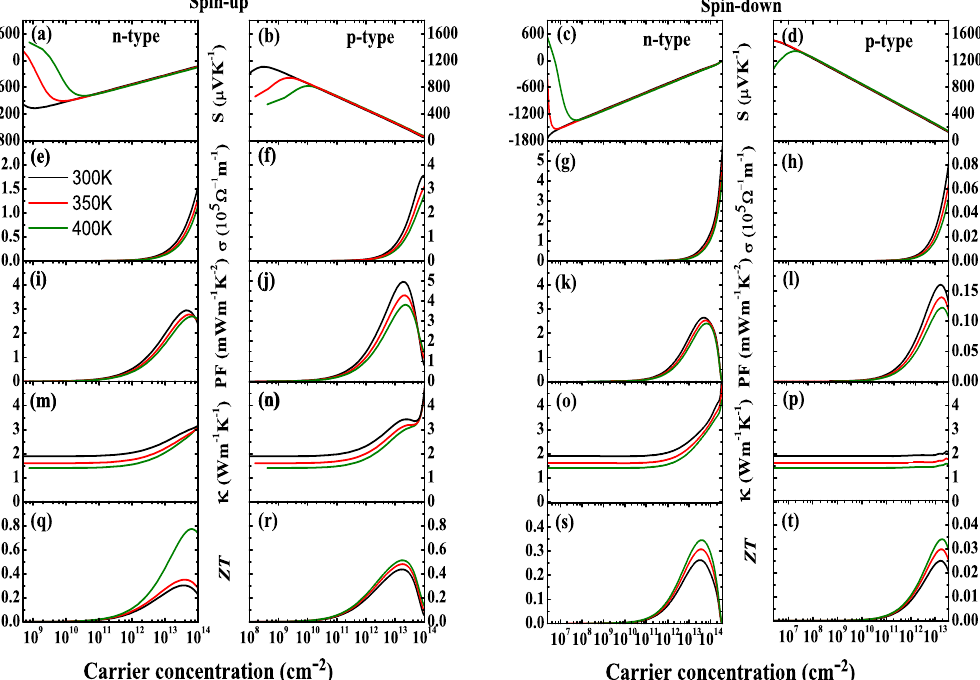
Figure 6. Seebeck coefficient S ( a – d ), electrical conductivity σ ( e – h ), power factor ( PF ) ( i – l ), total thermal conductivity ( m – p ) and zT value ( q – t ) of NiCl 3 monolayer for n-type and p-type in both directions as a function of the carrier concentration at the temperature of 300 K, 350 K, and 400